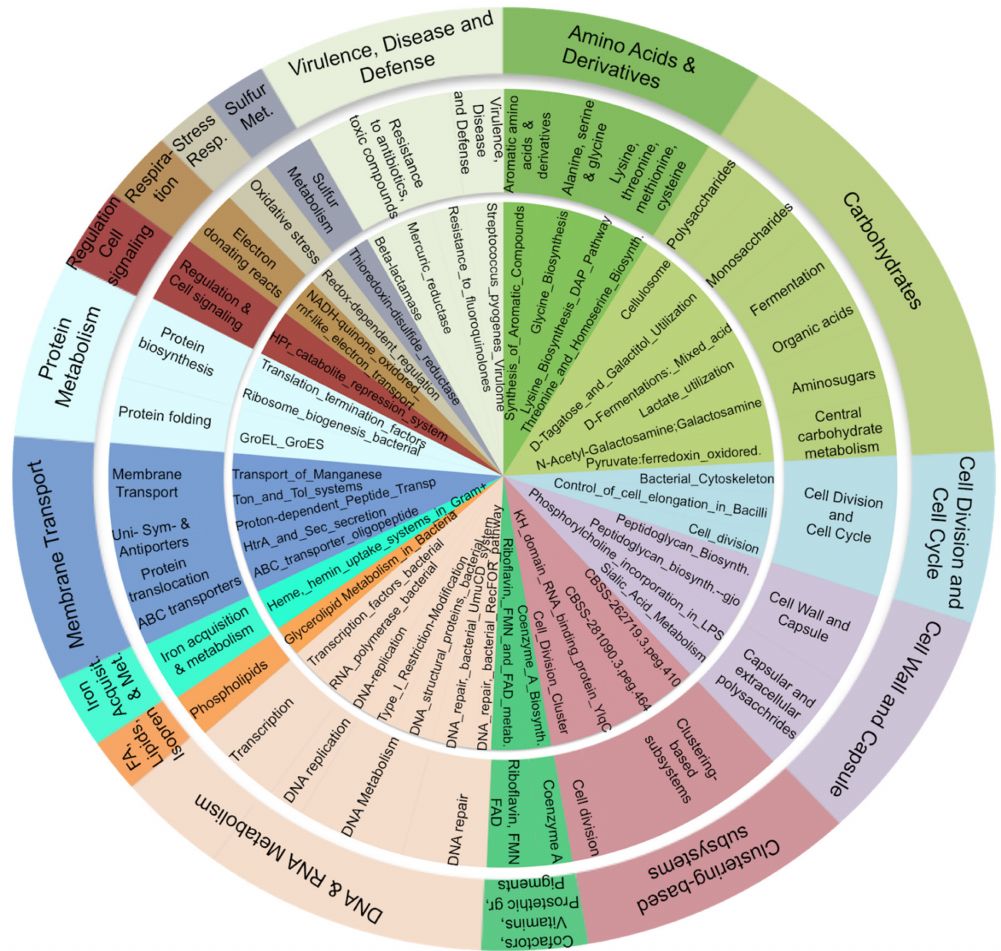
Figure 4. SEED subsystem hierarchy. The level 3 terms of SEED subsystem database (shown in the inner circle of the figure) resulted significant up-expressed genes ( p < 0.05, Log2FC > 1) between Lean (CO, n = 11) and Obese (OB, n = 12) samples using DESeq2 di ff erential abundance analysis. Terms were then grouped according to their belonging to higher levels 2 (middle circle) and 1 (outer circle). The slices size is proportional to the Log2FC values. The figure shows that the most altered functions concern the Amino acids, Carbohydrates, and Nucleic acids metabolism; the Clustering-based subsystem; the Virulence, Disease, and Defense mechanisms; and the Membrane